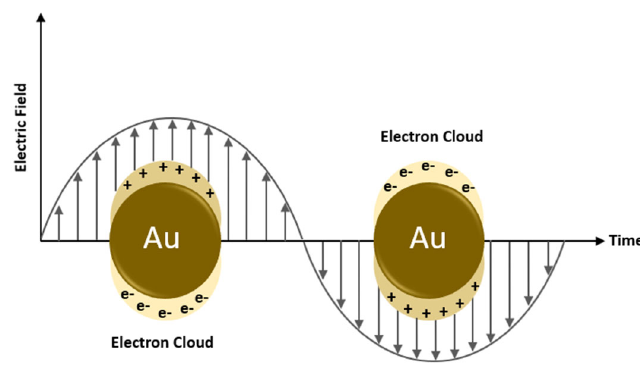
Figure 6. Surface plasmon resonance.